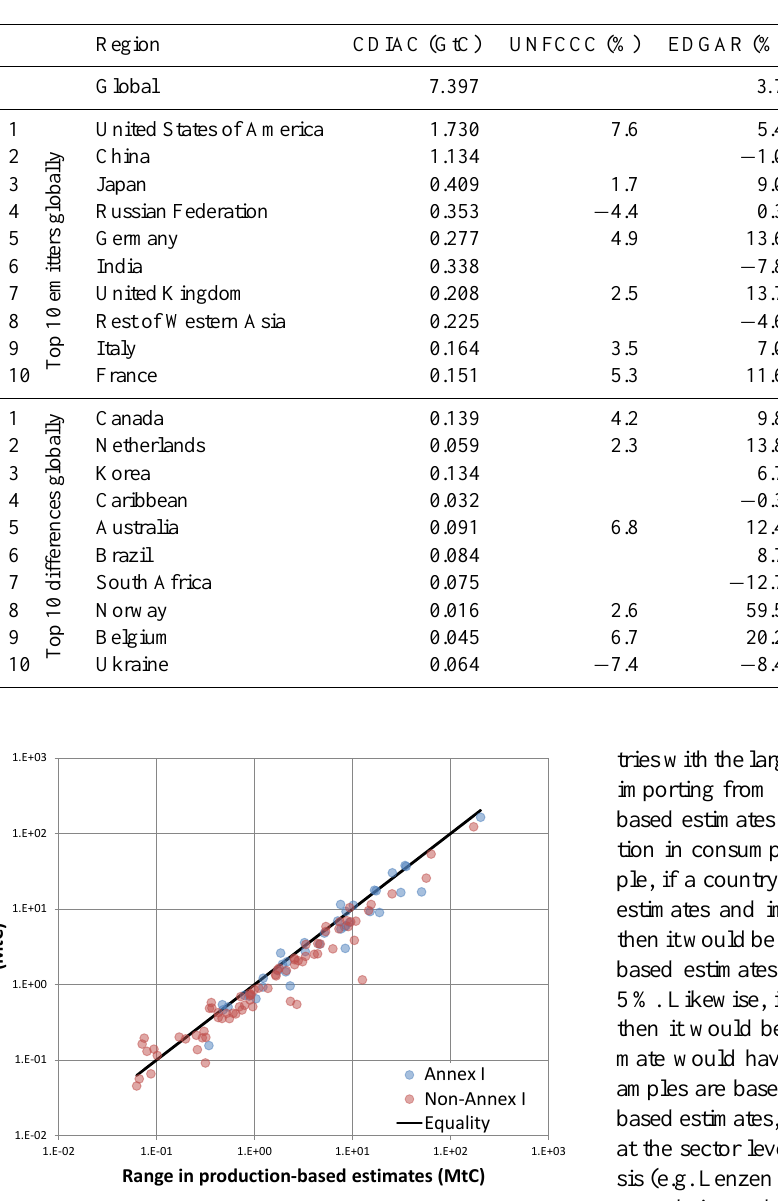
Fig. 4. The range in the production- and consumption-based es- timates (2004). The straight line is equal ranges (y = x). The consumption-based estimates are, counter-intuitively, more accu- rate than the production-based